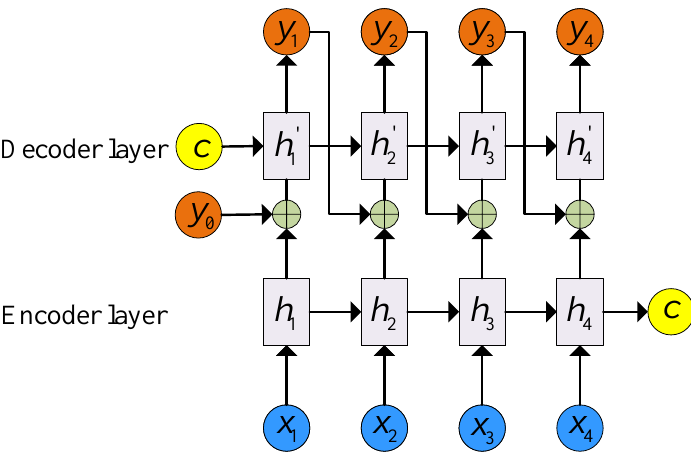
Figure 2. Improved seq2seq structure.